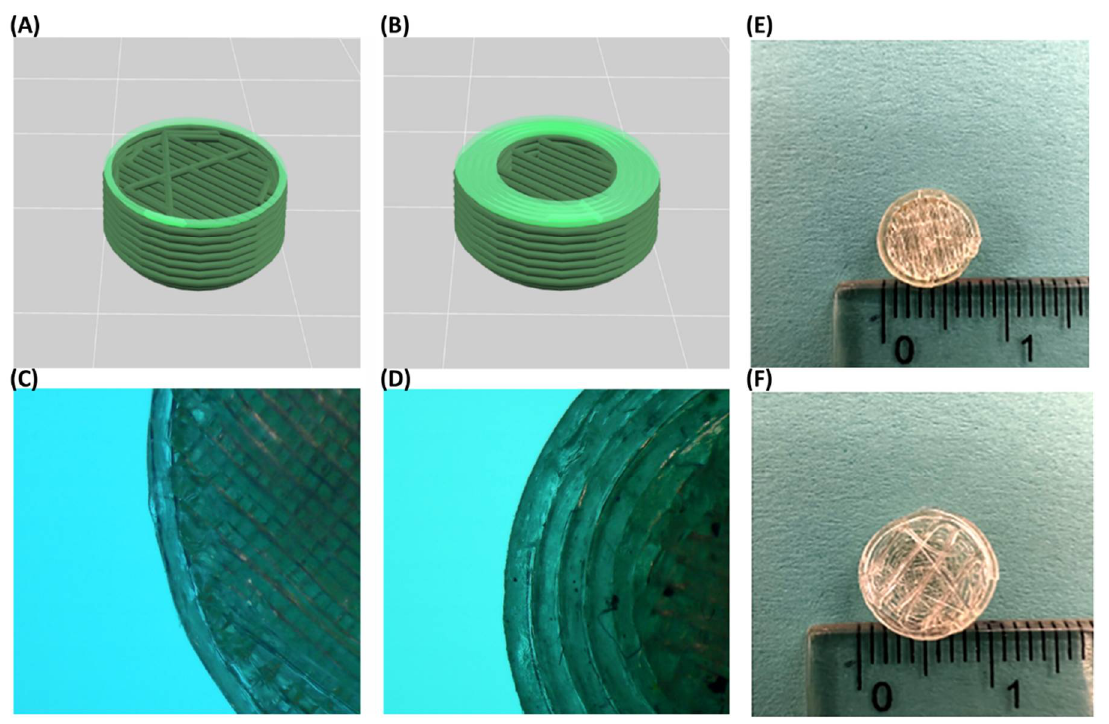
Figure 7. Rendering preview of 3D-printed tablet. ( A ) 1-shell printlet, ( B ) 5-shell printlet. Stereomi- croscopic image of section of the ( C ) 1-shell printlet, ( D ) 5-shell printlet. Difference between the size and internal structure of the printlets: ( E ) 1-shell compact printlet with 95% infill ( F ) Printlet with 1 shell and 20% infill.